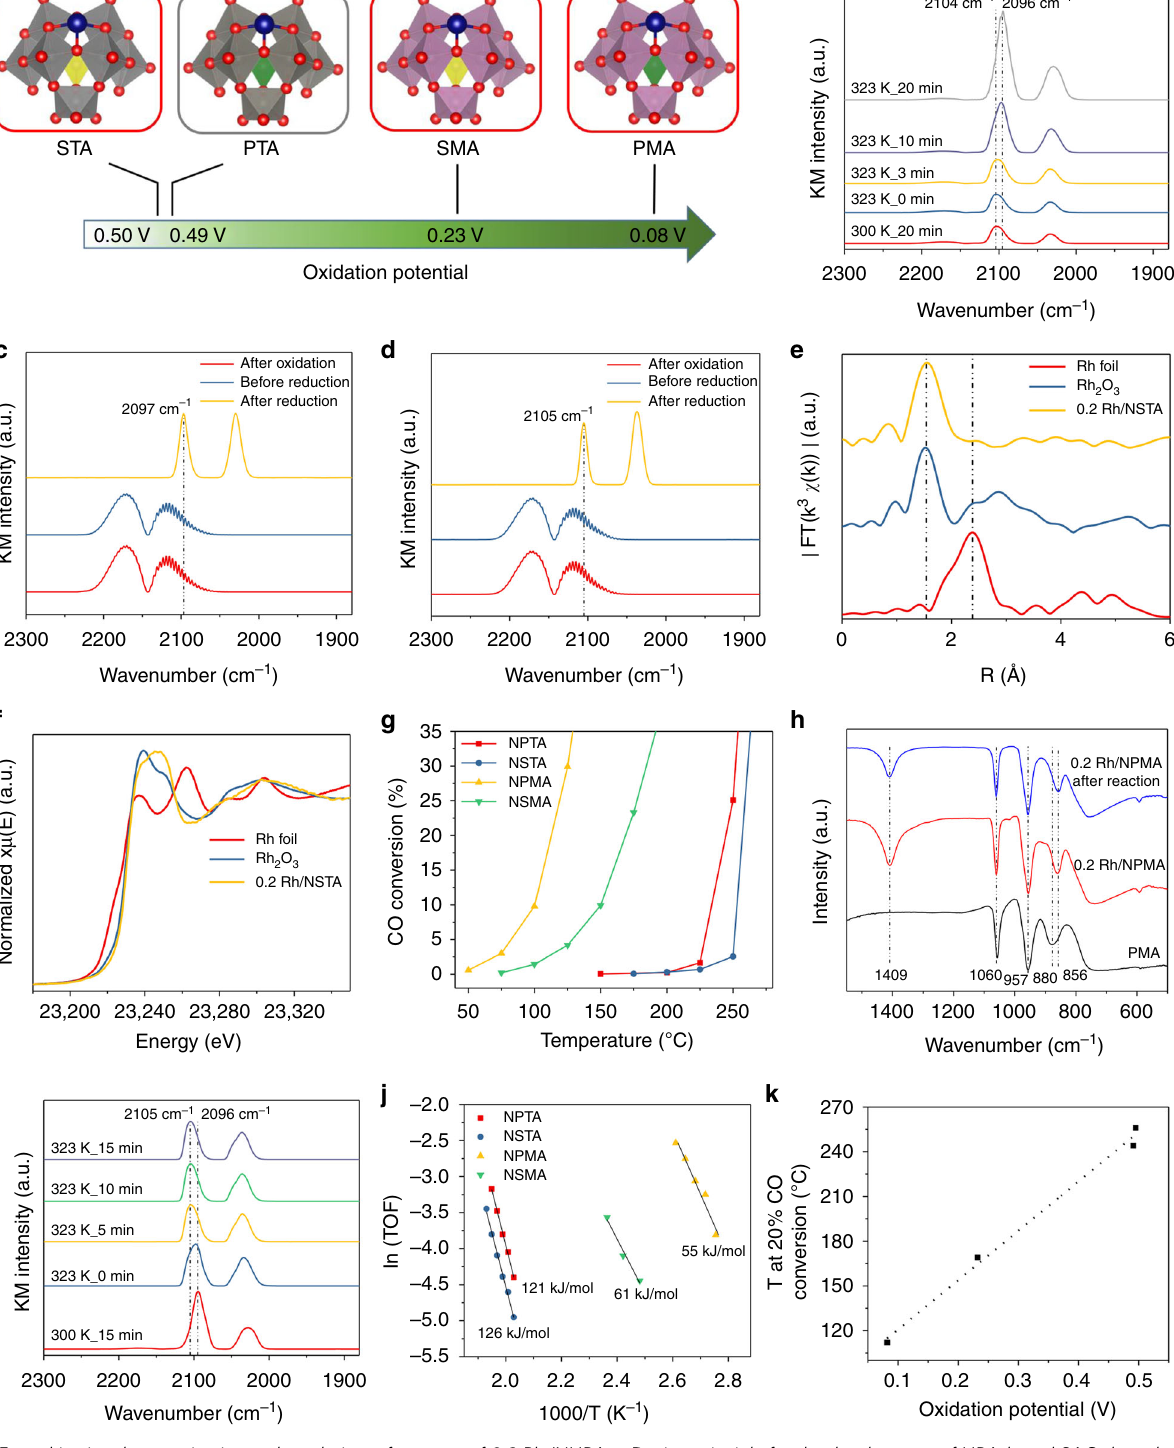
Fig. 5 Ex and in situ characterization and catalytic performance of 0.2 Rh/NHPA. a Design principle for the development of HPA-based SACs based on the oxidation potentials of 4 HPAs (gray indicates the initially studied and red the new catalysts); CO DRIFT for b 0.2 Rh/NPMA, c 0.2 Rh/NSMA and d 0.2 Rh/NSTA, oxidation for ( c , d ) was carried out at 523 K for 1 h under 5% O 2 and reduction was performed using 5% CO for 30 min at 373 K; e k 3 -weighted EXAFS spectra and f XANES for rhodium foil, Rh 2 O 3 and 0.2 Rh/NSTA; g Temperature-activity curves for Rh catalysts (0.2 wt%, 100 mg), GHSV = 24,000 h − 1 1% CO/1% O 2 , balance Ar; h ATR-IR spectra for PMA, 0.2 Rh/NPMA before and after CO oxidation up to 300 °C (573 K); i in situ DRIFT spectra for the reoxidation of reduced 0.2 Rh/NPMA under 5% O 2 atmosphere; j activation energies of the Rh catalysts (0.2 wt%) for CO oxidation; k correlation between T 20 and oxidation potential of the